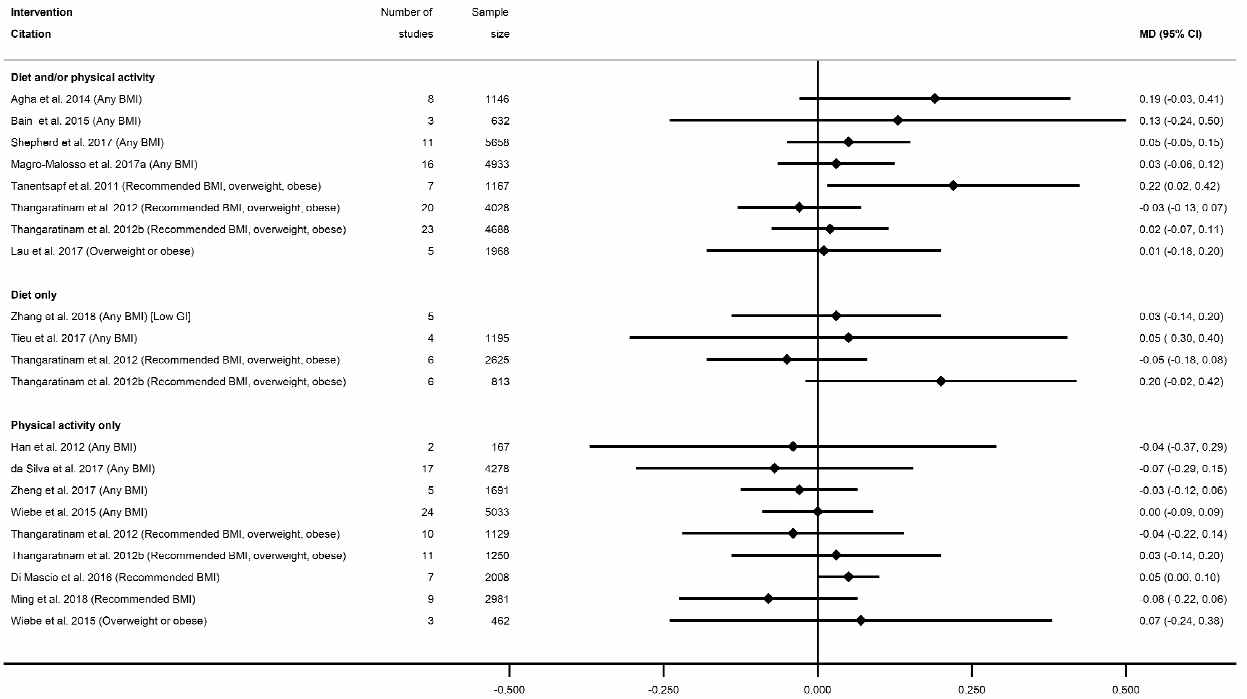
Figure 13. Forest plot of meta-analysis results for gestational age at delivery.